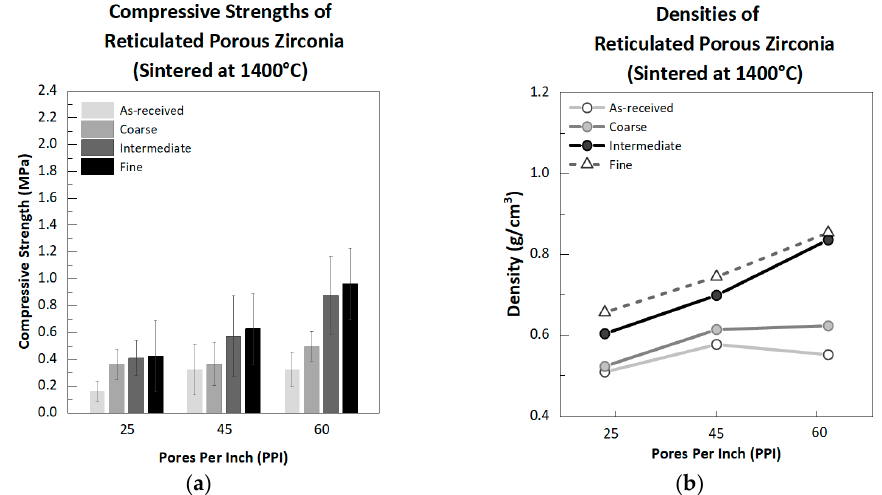
Figure 9. ( a ) Compressive strength outcomes of the reticulated porous zirconia prepared from the as-received, coarse, intermediate, and fine zirconia particles when sintered at 1400 °C, and ( b ) the corresponding density levels .